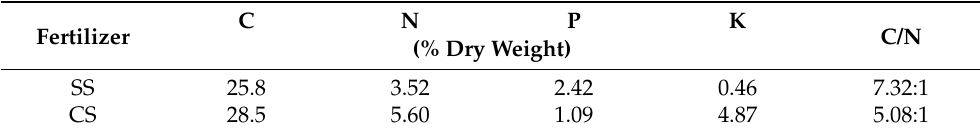
Table 3. The content of C, N, P, and K in organic fertilizers.